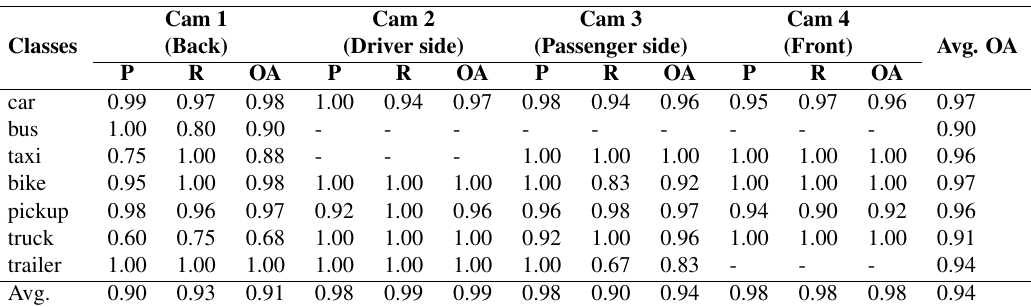
Table 2: Vehicle count and classification on the experimental setup of four cameras facing on different sides of the vehicles as shown in Figure 5.